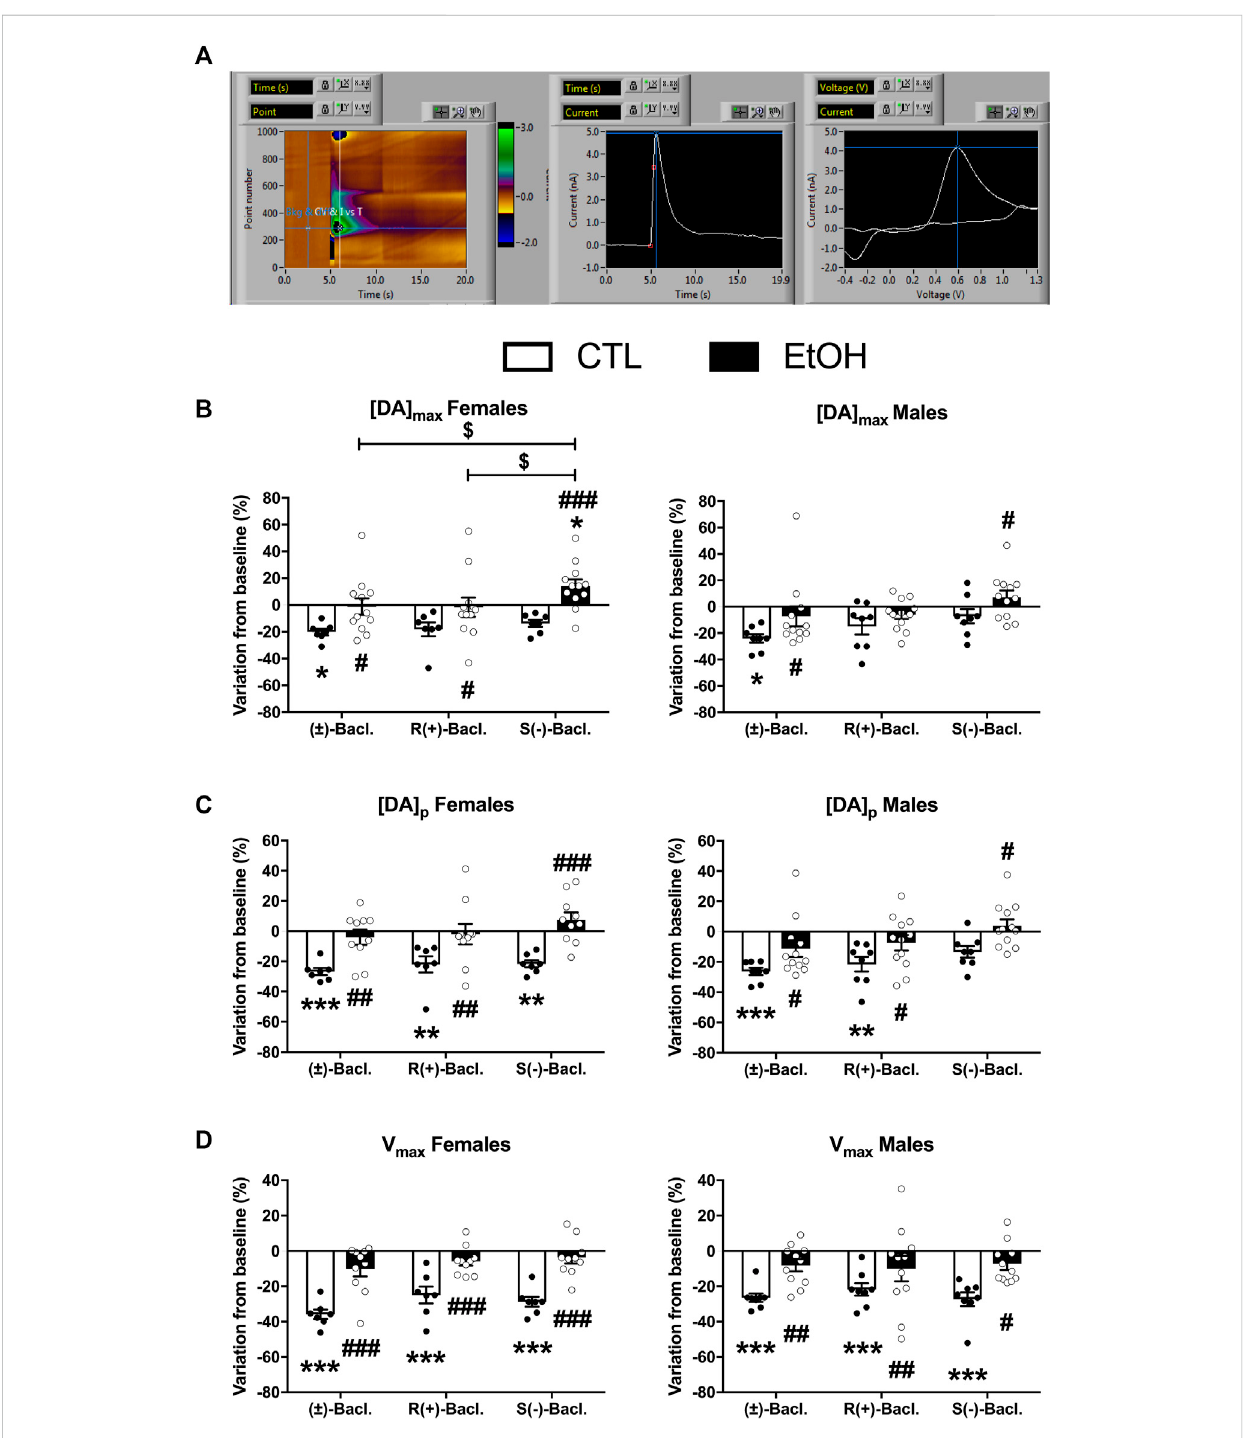
FIGURE 5 Effect of thedifferent forms of Baclofen (100 µM) on phasic dopaminergic transmission in thenucleus accumbens core in male and female rats and in both control and alcohol groups. (A) Characteristic voltamogramm of dopamine, recorded currents. (B – D) Effect of different forms of Baclofen on [DA] max , [DA] p and V max in both male and female rats, respectively. Results are expressed as mean ± SEM of variation from baseline